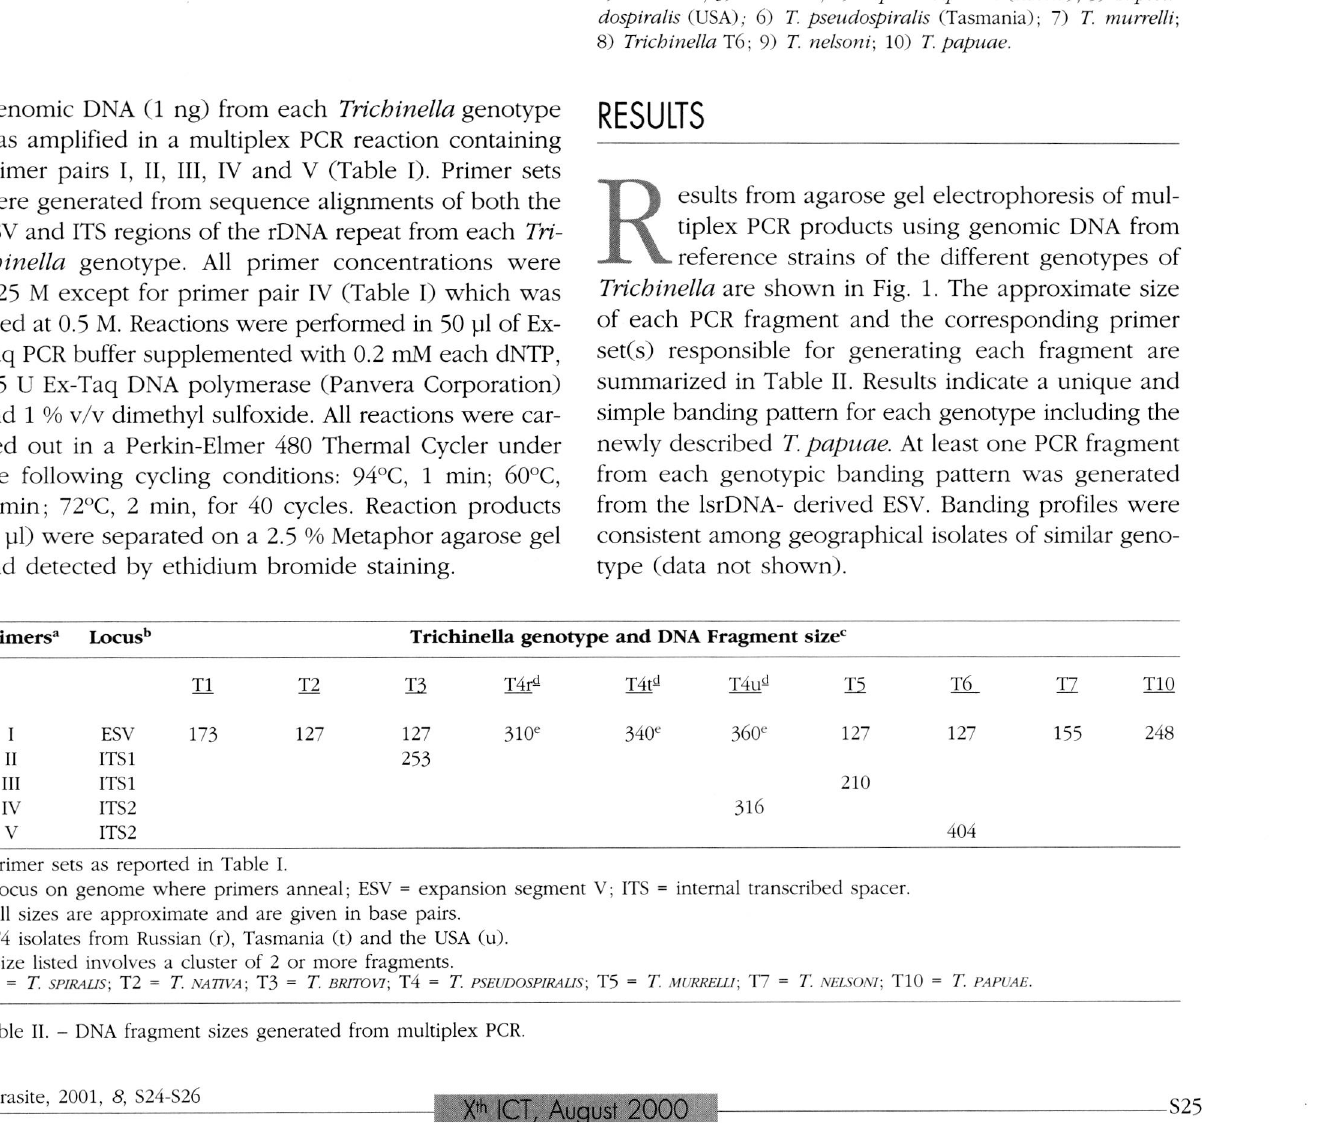
Table II. - DNA fragment sizes generated from multiplex PCR.